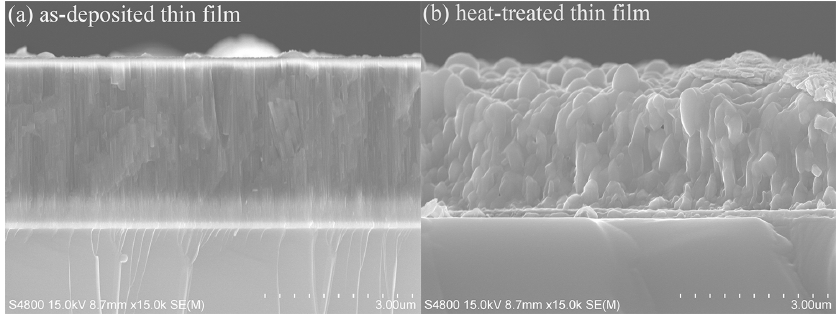
Figure 5. Fractured cross ‐ sectional SEM images of the Cr 2 O 3 thin film: ( a ) as ‐ deposited; ( b ) heat ‐ treated.